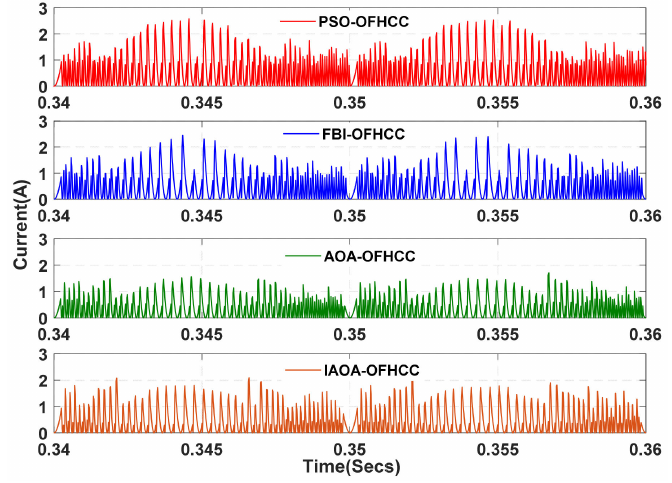
Figure 18. Simulation results showing current error for PSO-OFHCC, FBI-OFHCC, AOA-OFHCC, and IAOA-OFHCC.